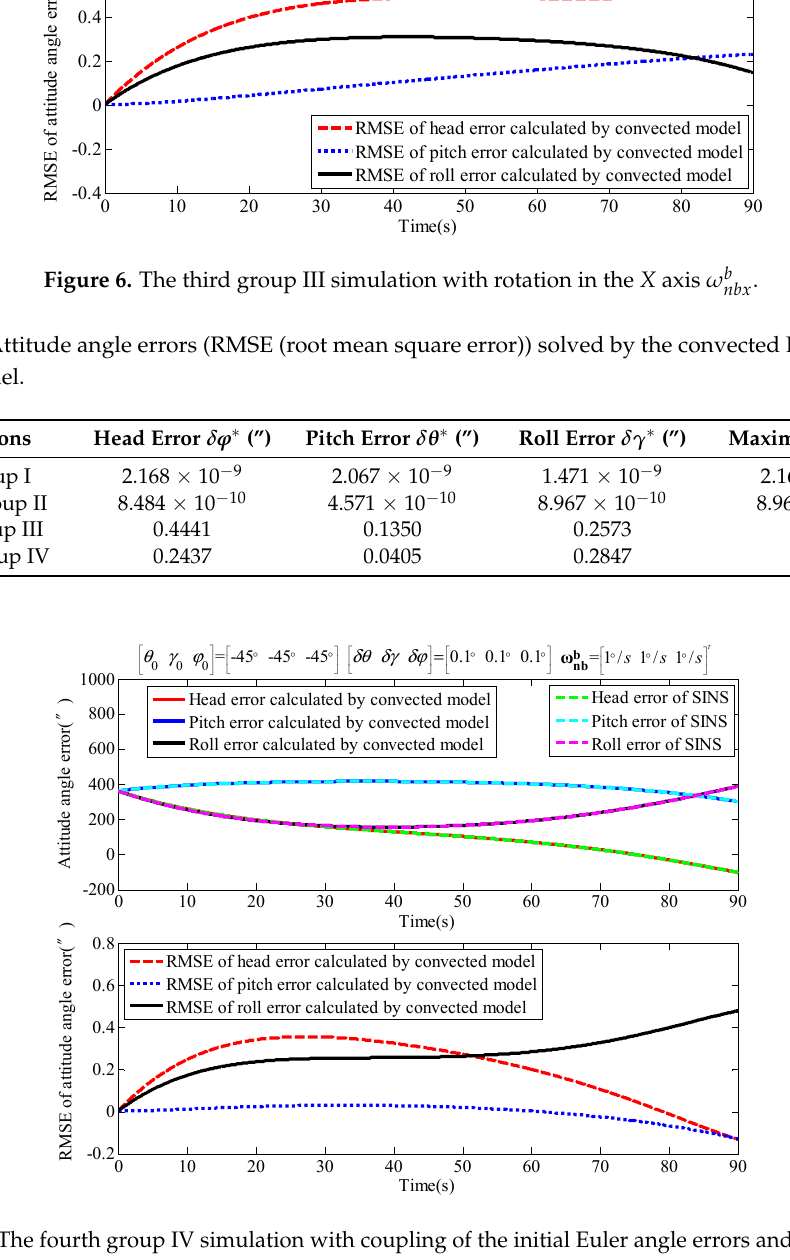
Figure 7. The fourth group IV simulation with coupling of the initial Euler angle errors and rotation in three axes.